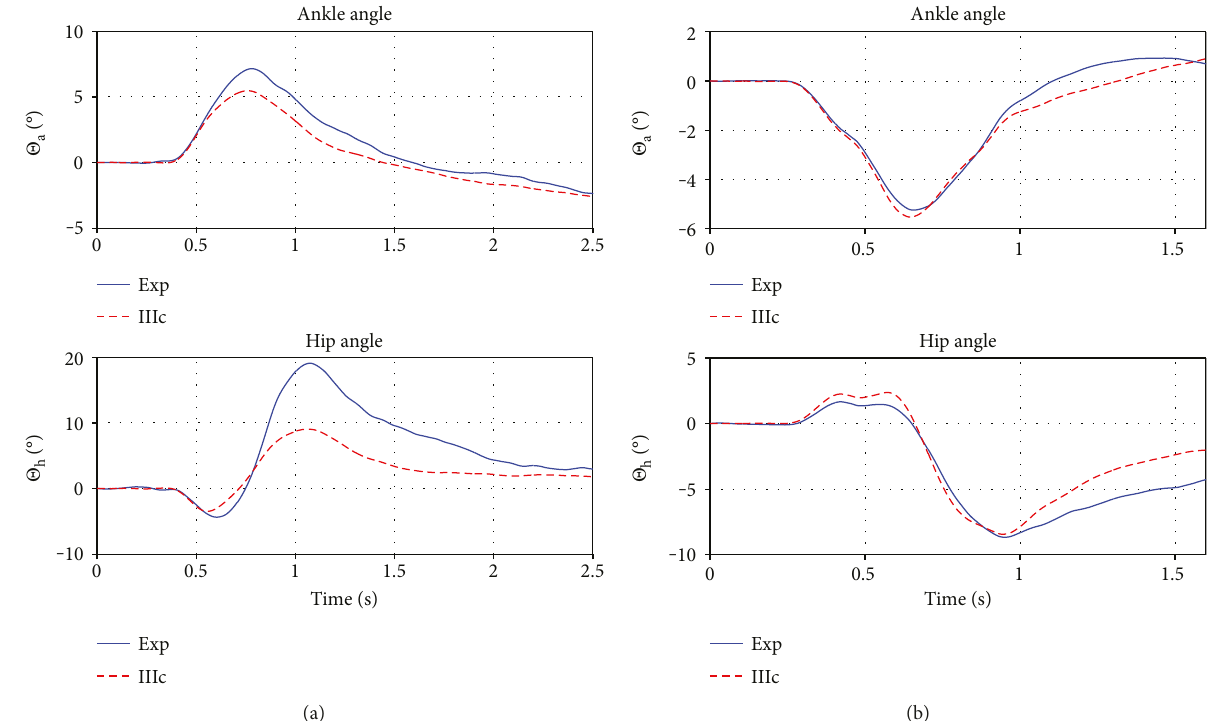
Figure 10: Best (a) and worst (b) prediction on S . Plotted are the ankle and hip angle in deg. over time in seconds. The red/dashed lines are te . Both trials are qualitatively correct and the experimental trials, and the blue/solid lines are the corresponding simulation of controller IIIc avrg the system is stabilized. The best prediction on the left shows a slight underestimation in the ankle and a slight overestimation in the hip at the end of trial, predicting the rest of the trajectory with high precision. The right (worst) prediction on the test set underestimates the experimental trajectory midtrial, while the beginning and end are predicted fi